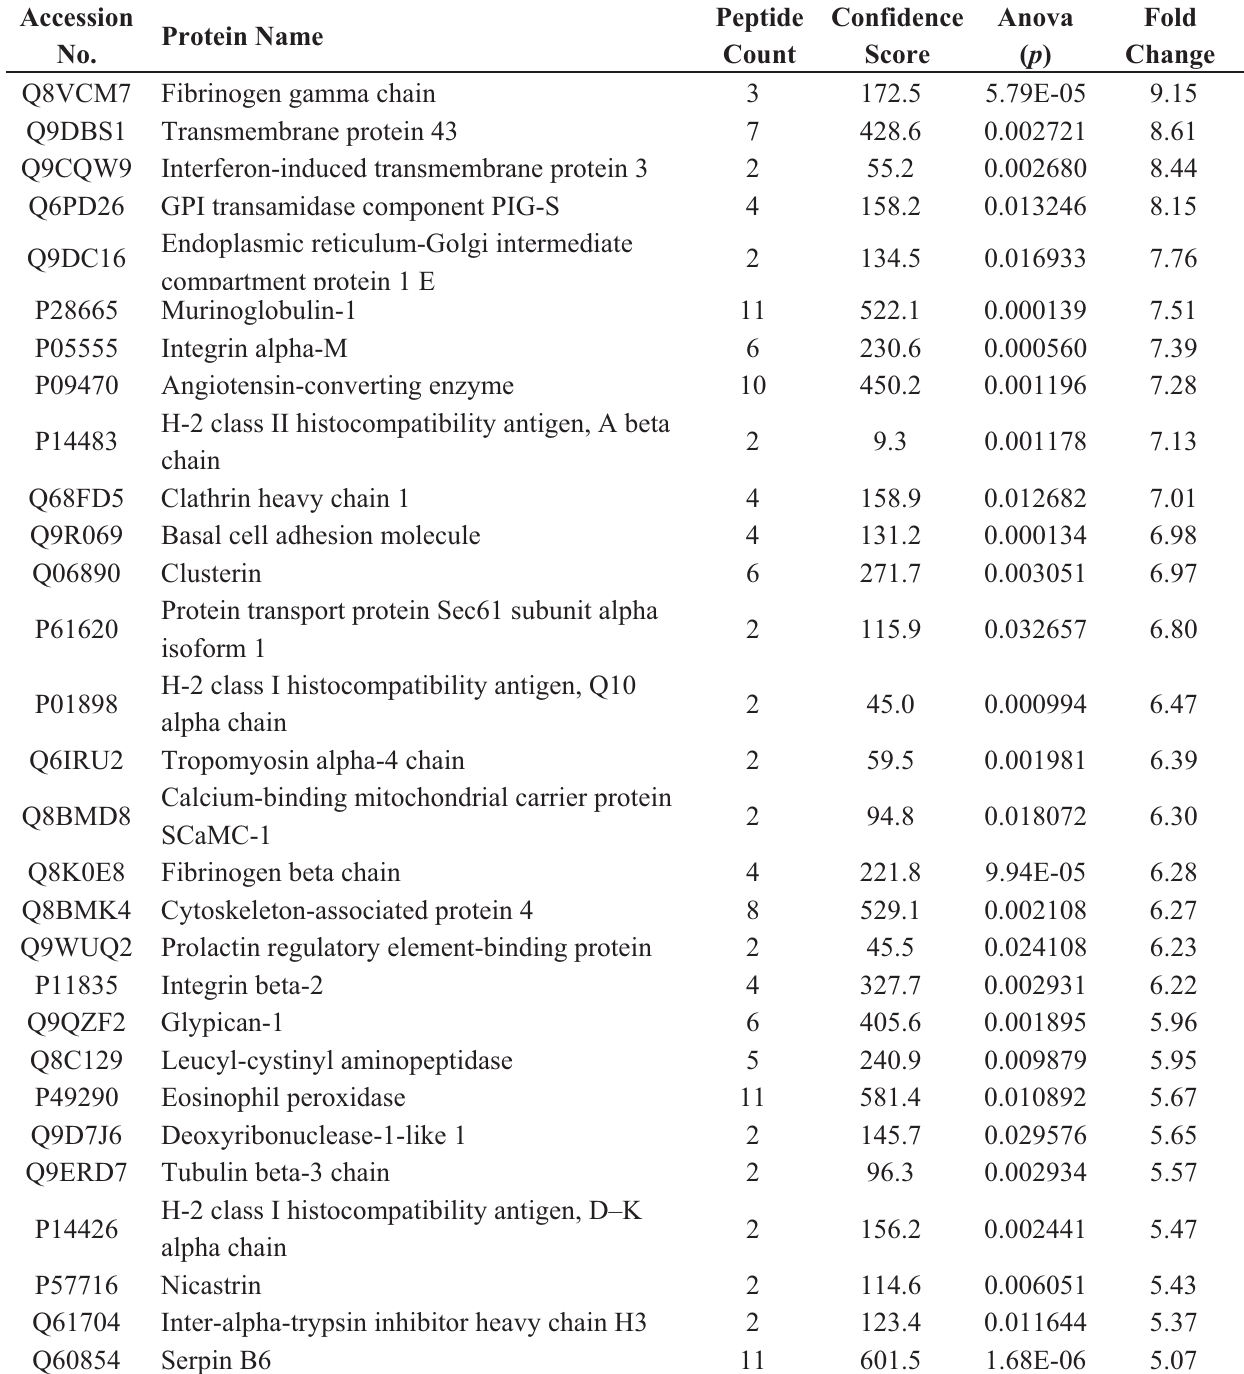
represent a compensatory mechanism to stabilise the dystrophin-deficient fibre surface. A very